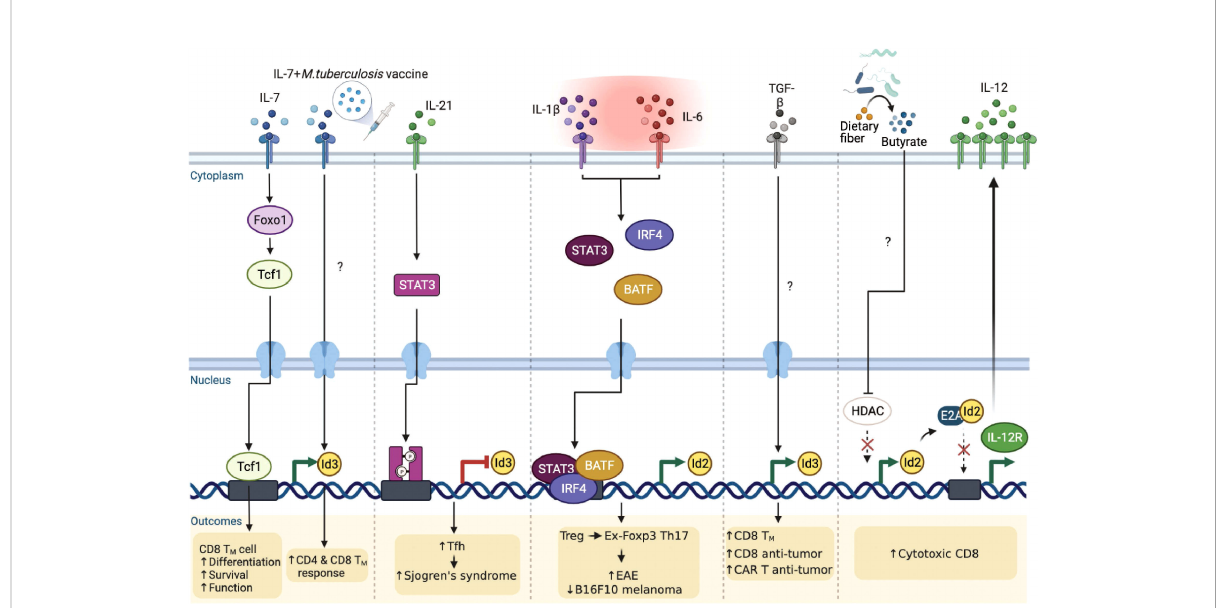
FIGURE 5 Extrinsic signaling pathways affect E-ID axis-mediated T cell function in infection, autoimmunity, and cancer. External signaling pathways affect the expression of E and ID proteins as well as the E-ID axis in various T cell subsets, resulting in changes in the phenotype of T cells and alleviating or exacerbating diseases (Foxo1, Forkhead Box O1; STAT3, Signal Transducer And Activator Of Transcription 3; IRF4, Interferon Regulatory Factor 4; BATF, Basic Leucine Zipper ATF-Like Transcription Factor; TGF- b , Transforming growth factor b ; HDAC, Histone deacetylase; T M , Memory T cells; CAR, Chimeric Antigen Receptor). This fi gure was created with